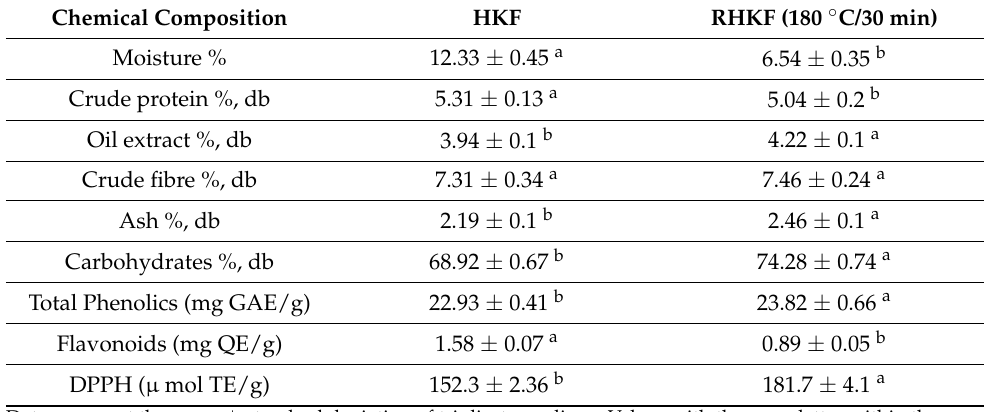
Table 1. The chemical composition of raw (HKF) and roasted Hass avocado kernel flour (RHKF). Chemical